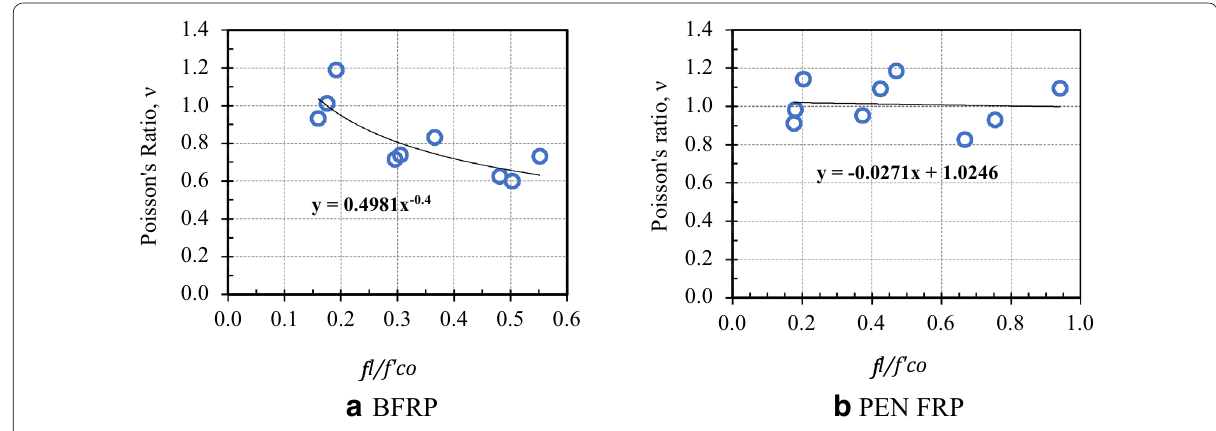
Fig. 9 Relationship of confinement pressure and ultimate Poisson’s Ratio at maximum